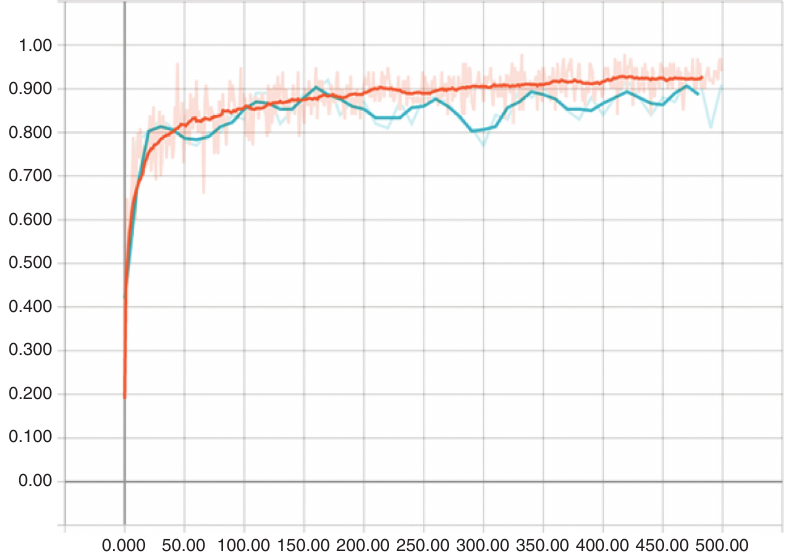
Figure 5: Training (Orange) vs. Test (Blue) Accuracy on Our Trained